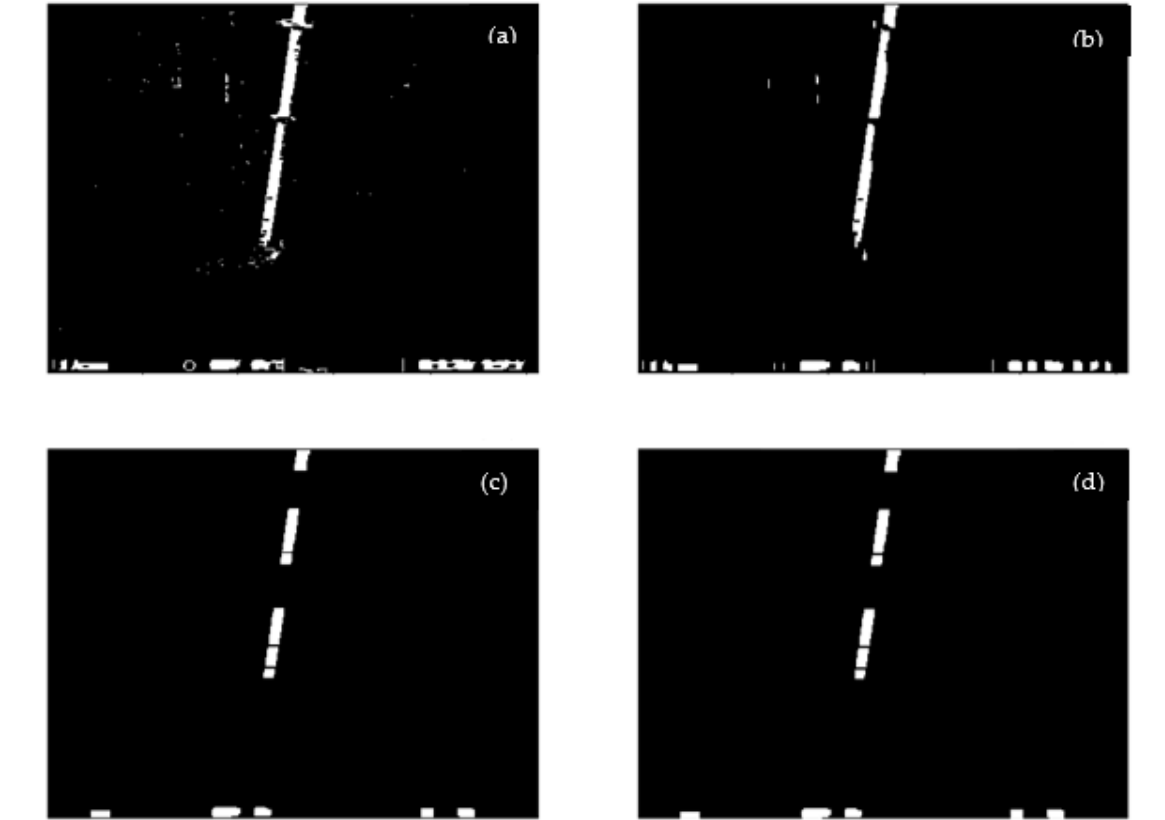
Figure 8. The effect after the opening and closing operation. ( a ) The image from Figure 7b by closing operation. ( b ) The image from ( a ) by horizontal opening operation. ( c ) The image from ( b ) by vertical opening operation. ( d ) The image from ( c ) by horizontal opening operation.